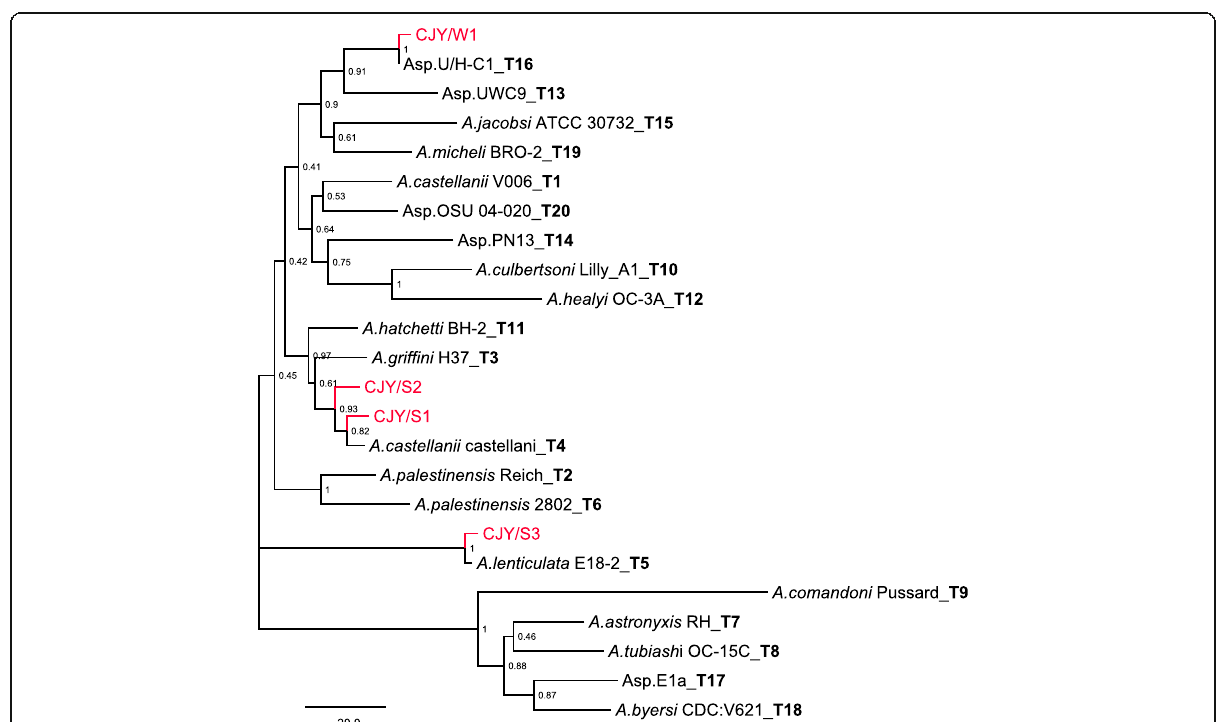
Fig. 2 Dendrogram of Acanthamoeba strains based on 18S rDNA sequences. The neighbor-joining tree reflects the affiliation of the Acanthamoeba sp. strains CJY/S1, CJY/S2, CJY/S3, and CJY/W1 with the reference strains of genotypes T1 – T20. T1: A. castellanii CDC: 0981:V006, GenBank accession no. U07400; T2: A. palestinensis , U07411; T3: A. griffini H37, S81337; T4: A. castellanii Neff, U07416; T5: A. lenticulata E18-2, U94735; T6: A. palestinensis 2802, AF019063; T7: A. astronyxis , AF019064; T8: A. tubiashi OC-15C, AF019065; T9: A. comandoni , AF019066; T10: A. culbertsoni A-1, AF019067; T11: A. hatchetti BH-2, AF019068; T12: A. healyi , AF019070; T13: Acanthamoeba sp. UWC9, AF132134; T14: Acanthamoeba sp. PN13, AF333609; T15: A. jacobsi ATCC 30732, AY262360; T16: Acanthamoeba sp. U/H-C1, AY026245; T17: Acanthamoeba sp. E1a, GU808277; T18: A. byersi CDC:V621, KC822464; T19: A micheli